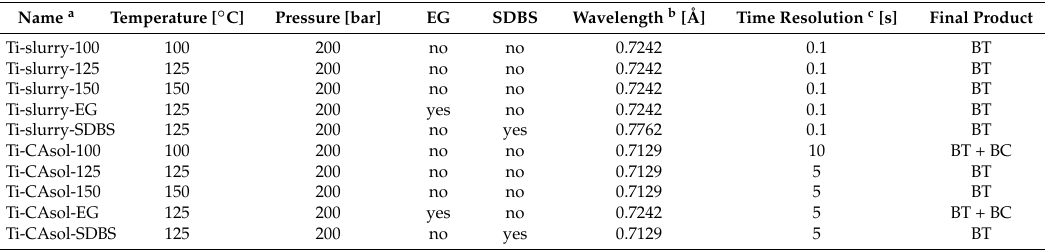
Table 1. Overview of sample names, temperature, pressure, X-ray wavelength, and time resolution for the in situ X-ray diffraction experiments. Also, indicated is the surfactants used for each experiment and the final